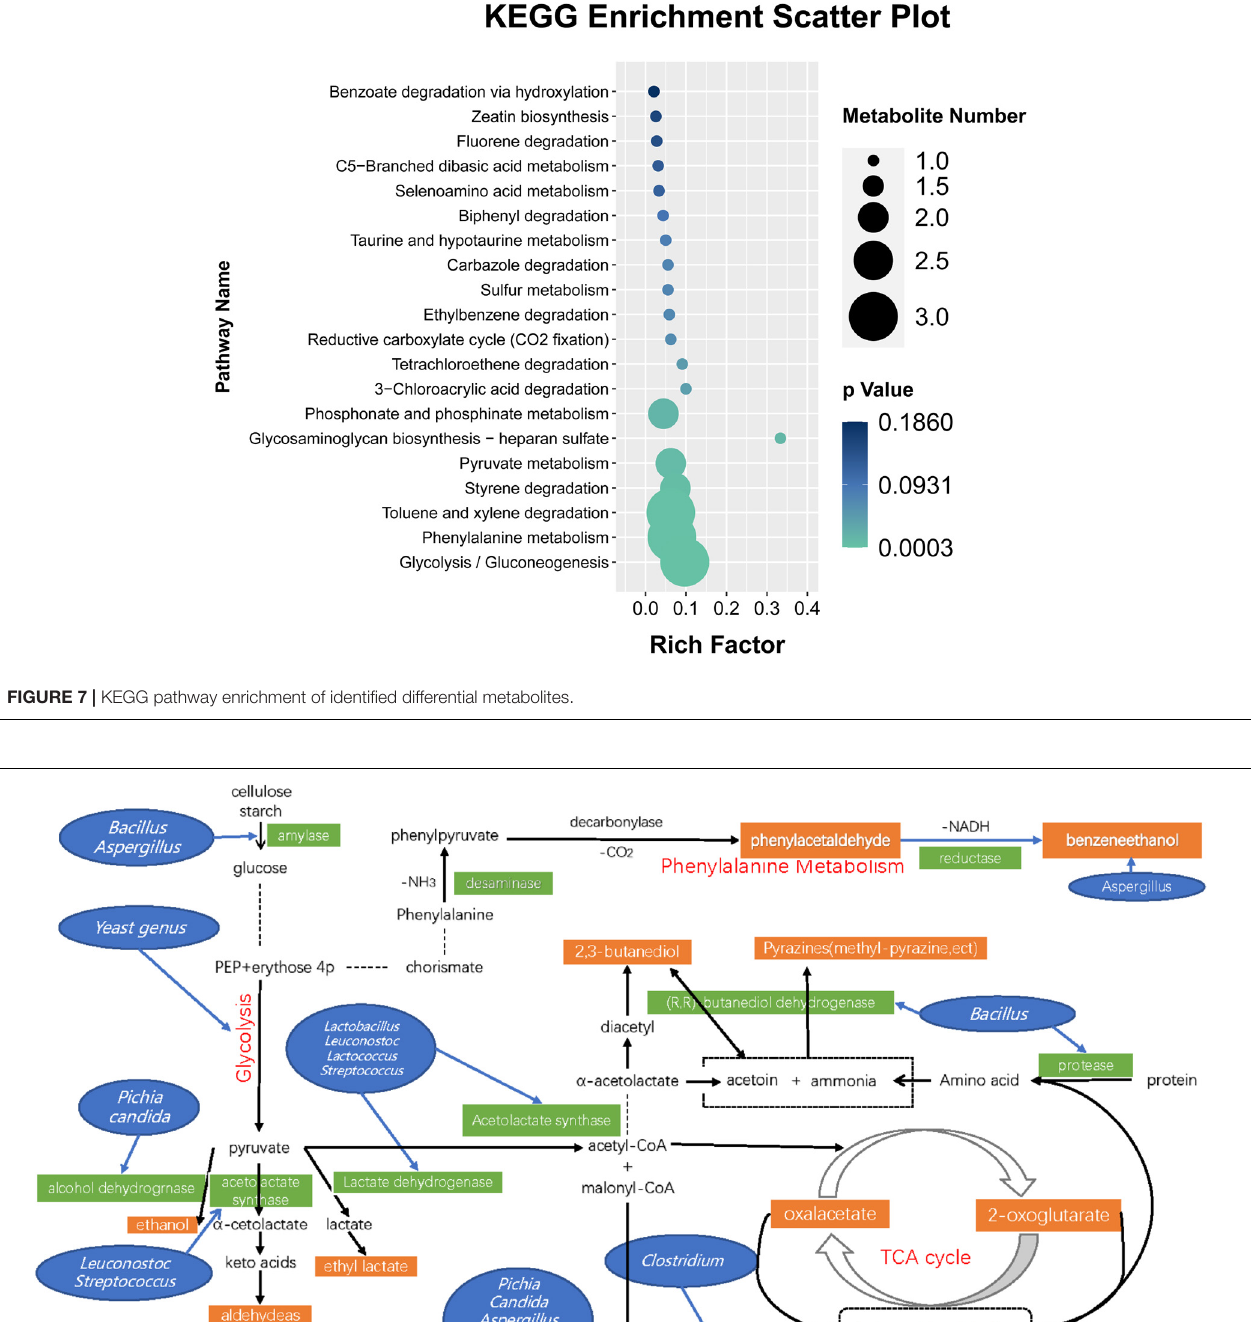
Frontiers in Microbiology |